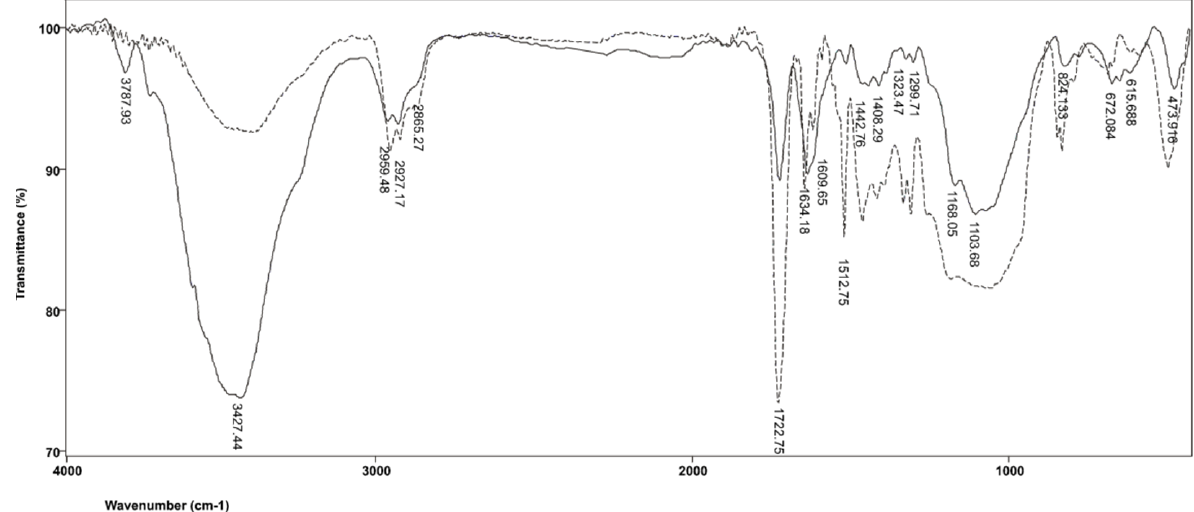
Figure 5. FTIR spectrum produced by the Variolink II resin before and after polymerization. The FTIR peak assignments for Maxcem Elite, RelyX ARC, SpeedCEM and Variolink II commercial resin-based cement material before and after polymerization are shown in Table 6. Table 6. FTIR peak assignments for resin-based dental cement materials.